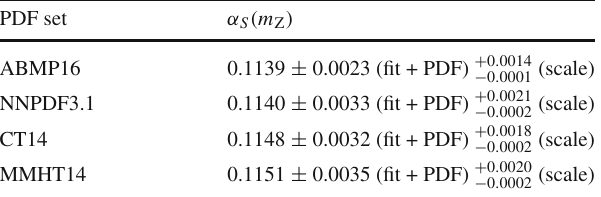
Table 6 Values of m t ( m t ) obtained from the comparison of the σ tt measurement with the NNLO predictions using different PDF sets. The first uncertainty shown comes from the experimental, PDF, and α S ( m Z ) uncertainties, and the second from the variation in the renormalization and factorization